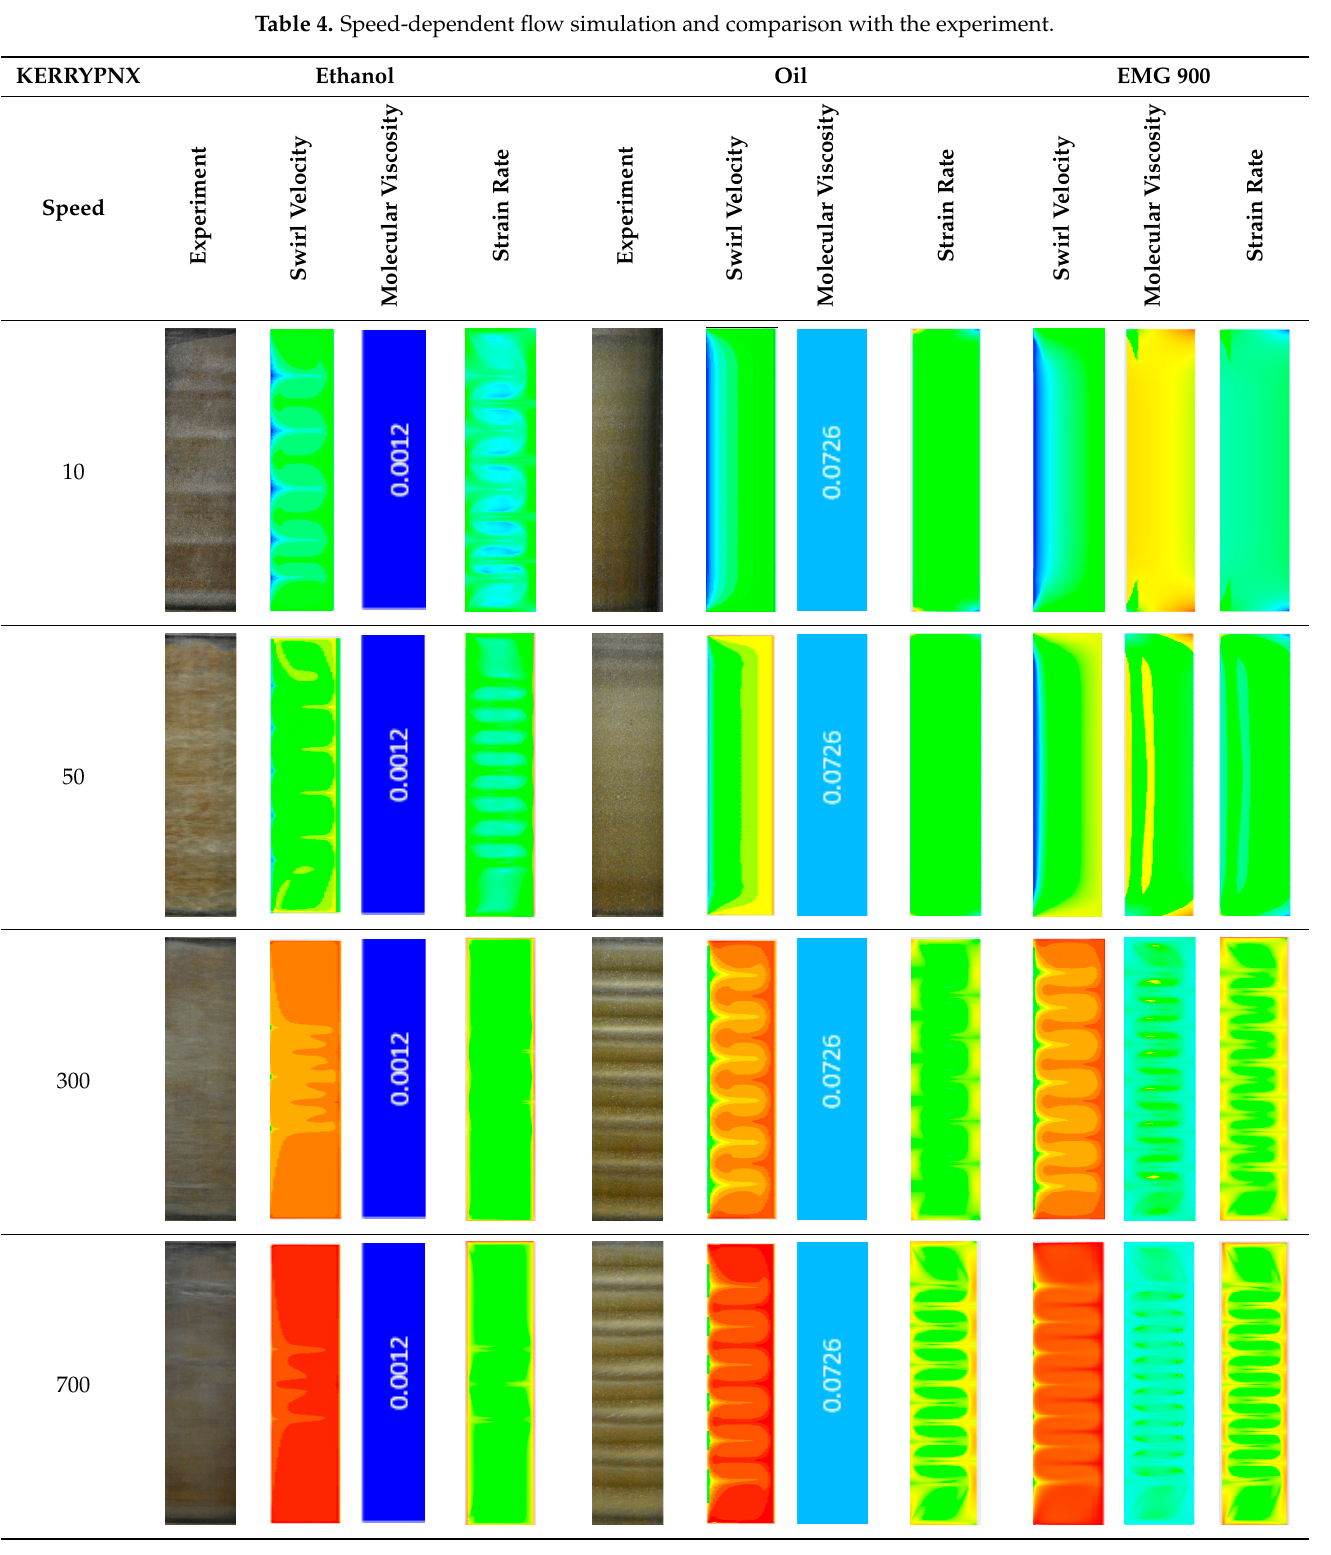
Table 5. Mean values of the viscosity mol., turb., eff. and strain rate.